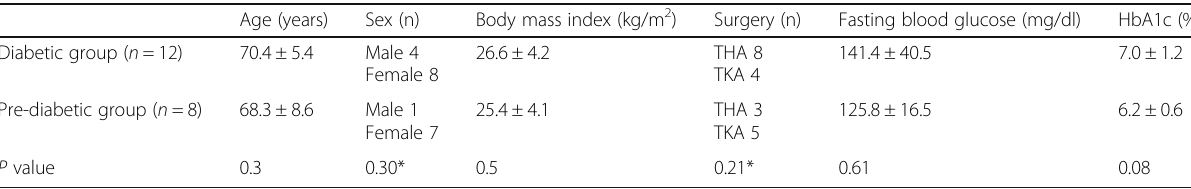
Table 1 Characteristics of the diabetic and prediabetic groups